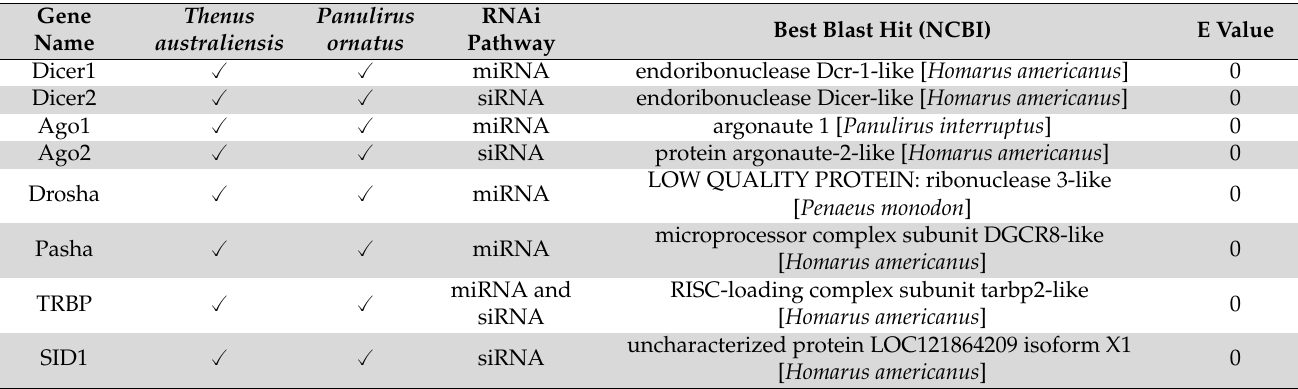
Table 1. RNA interference genes identified in T. australiensis and P. ornatus , which pathway they belong to, the best blast hit from NCBI non-redundant protein database, and e-value for these blast